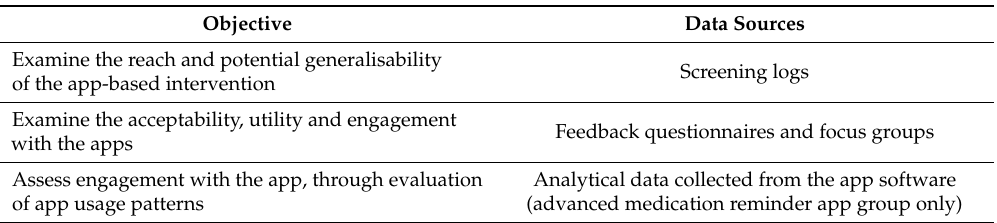
Table 1. MedApp-CHD mixed-methods evaluation